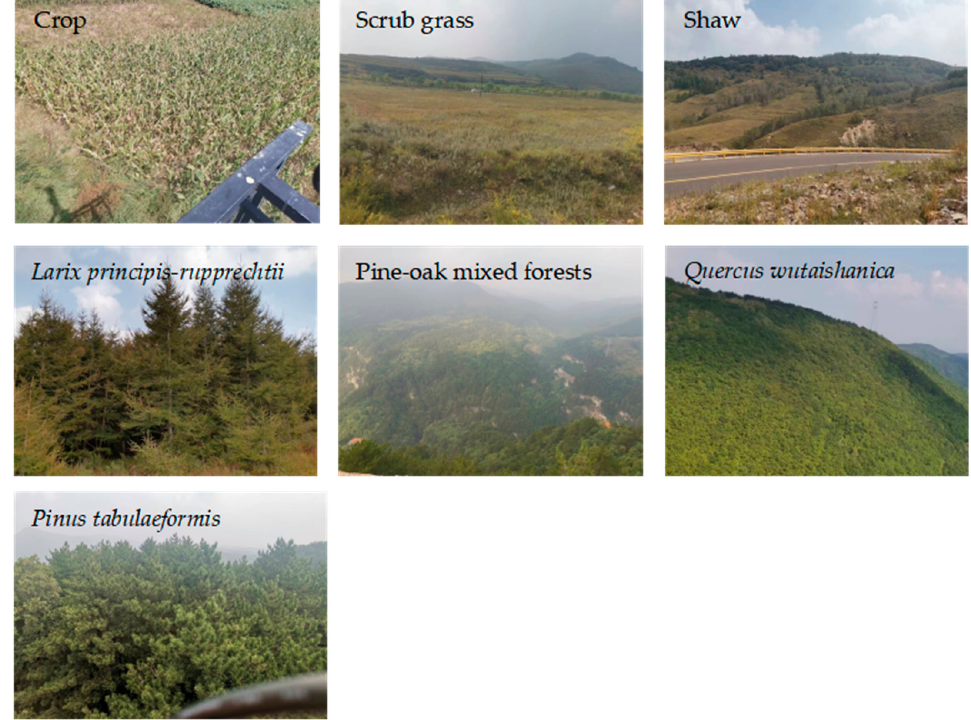
Figure 2. Seven main vegetation types in the LMNR.